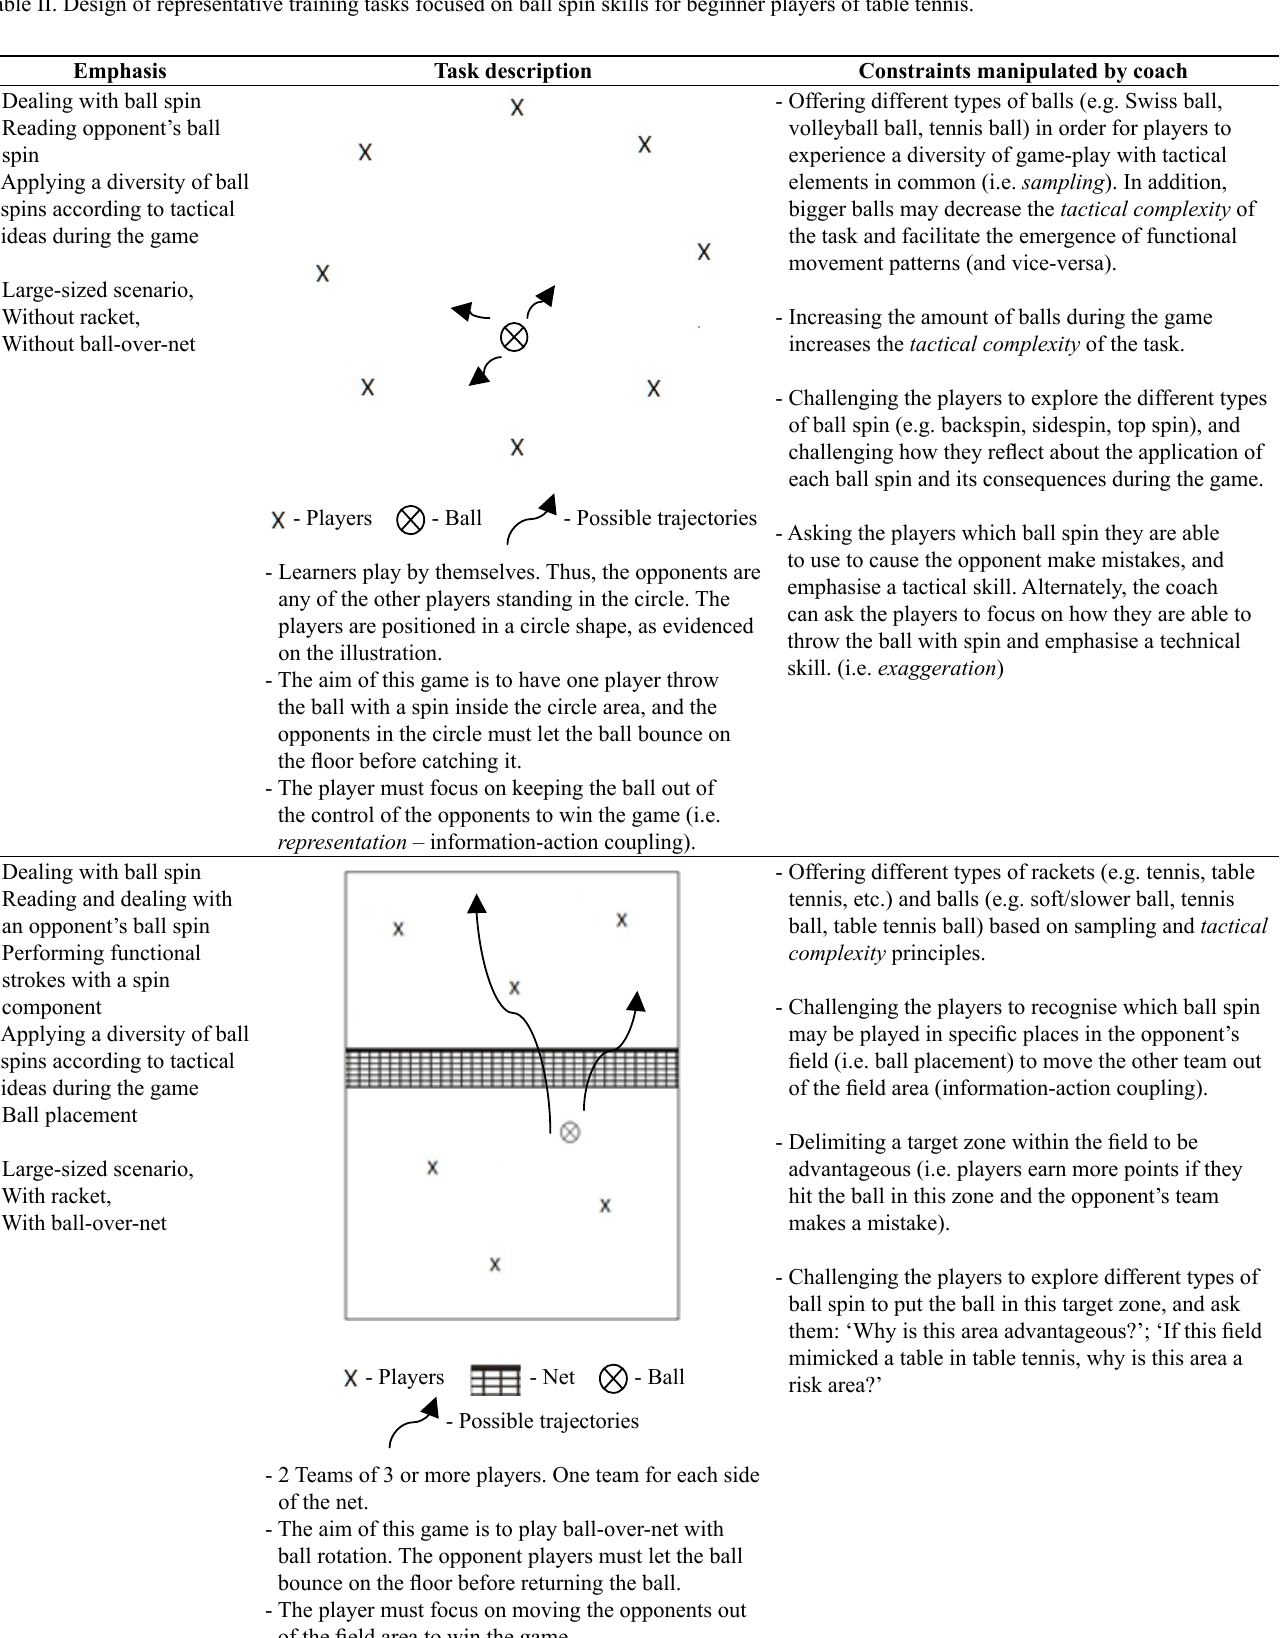
Table II. Design of representative training tasks focused on ball spin skills for beginner players of table tennis.